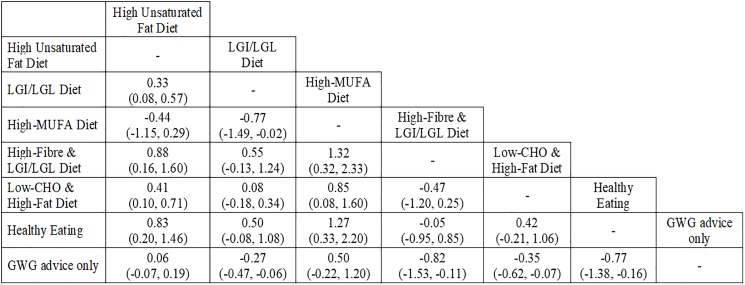
Difference in median effect with 95% credible intervals between diets given in addition to GWG advice on fasting glucose in mmol/l.Abbreviations: CHO, carbohydrate; LGI, low-glycemic index; LGL, low-glycemic load; GWG, gestational weight gain; MUFA, monounsaturated fatty acids. The value in each cell expresses the median difference and its 95% credible intervals between the dietary pattern in the column and the dietary pattern in the row (e.g. the median difference of the high-unsaturated fat diet compared to LGI/LGL diet is 0.33 mmol/L (95% CrIs = 0.08, 0.57 mmol/L).